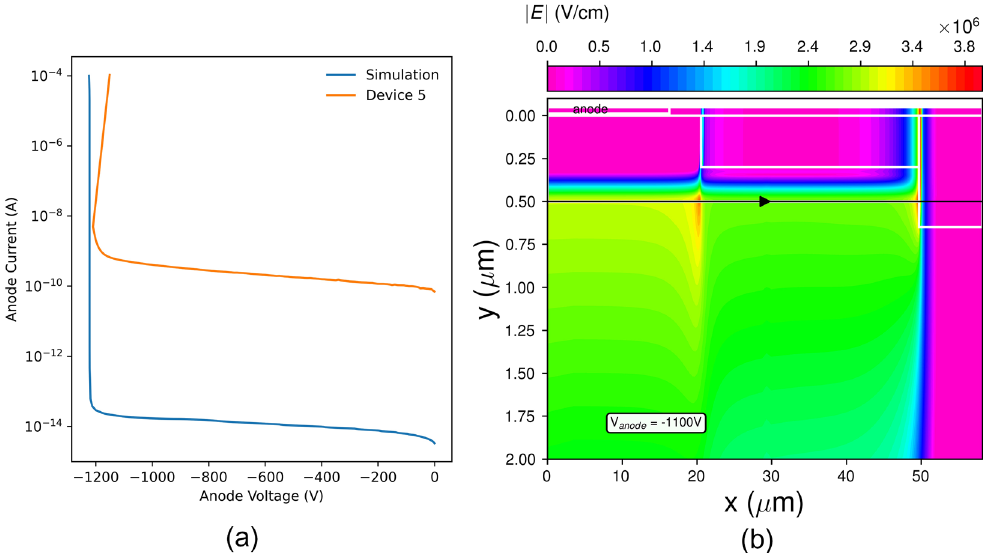
Figure 7. Results of simulations of reverse breakdown of the defect-free device under study. ( a ) shows a comparison between the simulated and measured reverse IV characteristics of a representative defect-free device. A contour plot of the electric field in the edge termination region at an anode bias of − 1200 V is shown in ( b ).